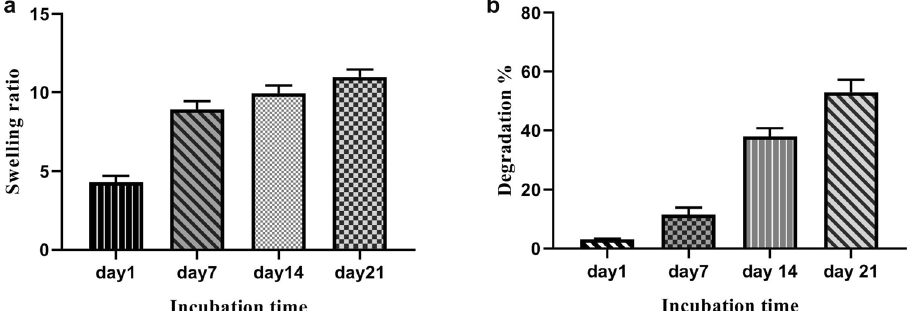
Figure 5. The effects of incorporating nanochitosan into the PPy–Alg composite on swelling and degradation the scaffold: ( a ) swelling ratio for 1, 7, 14, 21 days, ( b ) degradation study of scaffold for 1, 7, 14, 21